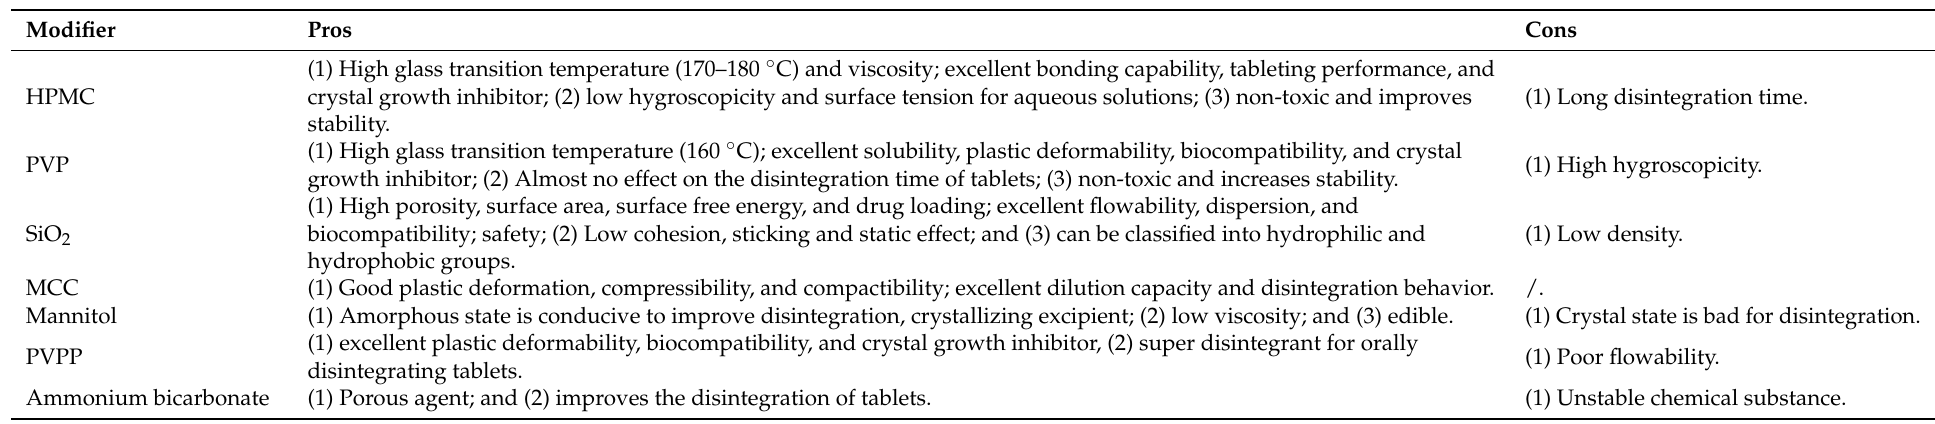
Table 6. Pros and cons of